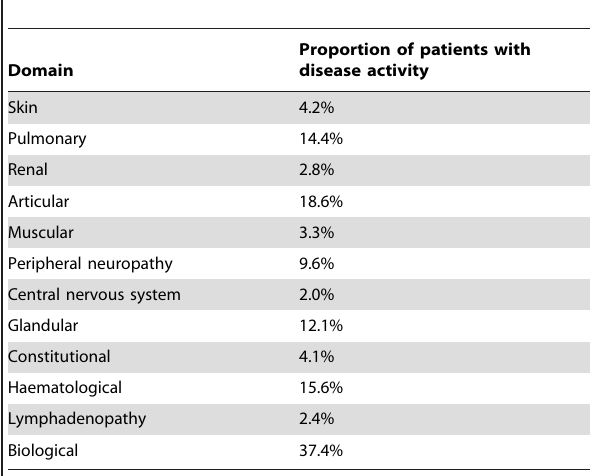
Table 2. Patients with active disease in the various ESSDAI domains at enrollment.